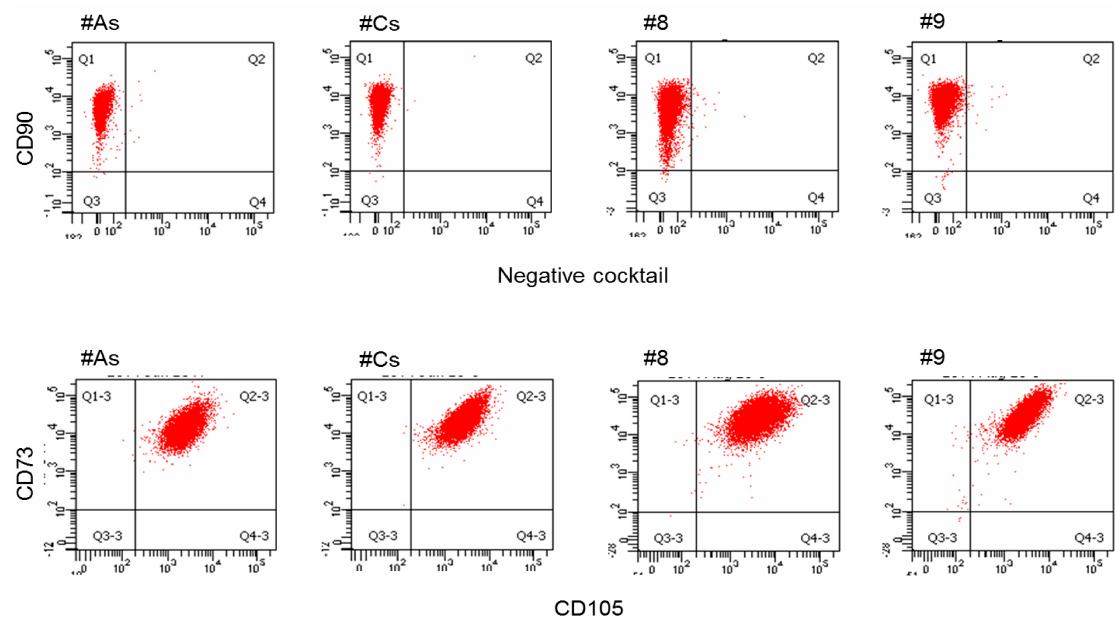
Figure 3. Flow cytometry data of cells derived from healthy ( left panel ) and diseased ( right panel ) gingiva both show identical expression of cell-surface markers characteristic of MSC. Cells were labeled with fluorescent conjugated antibodies and characterized using flow-cytometry.